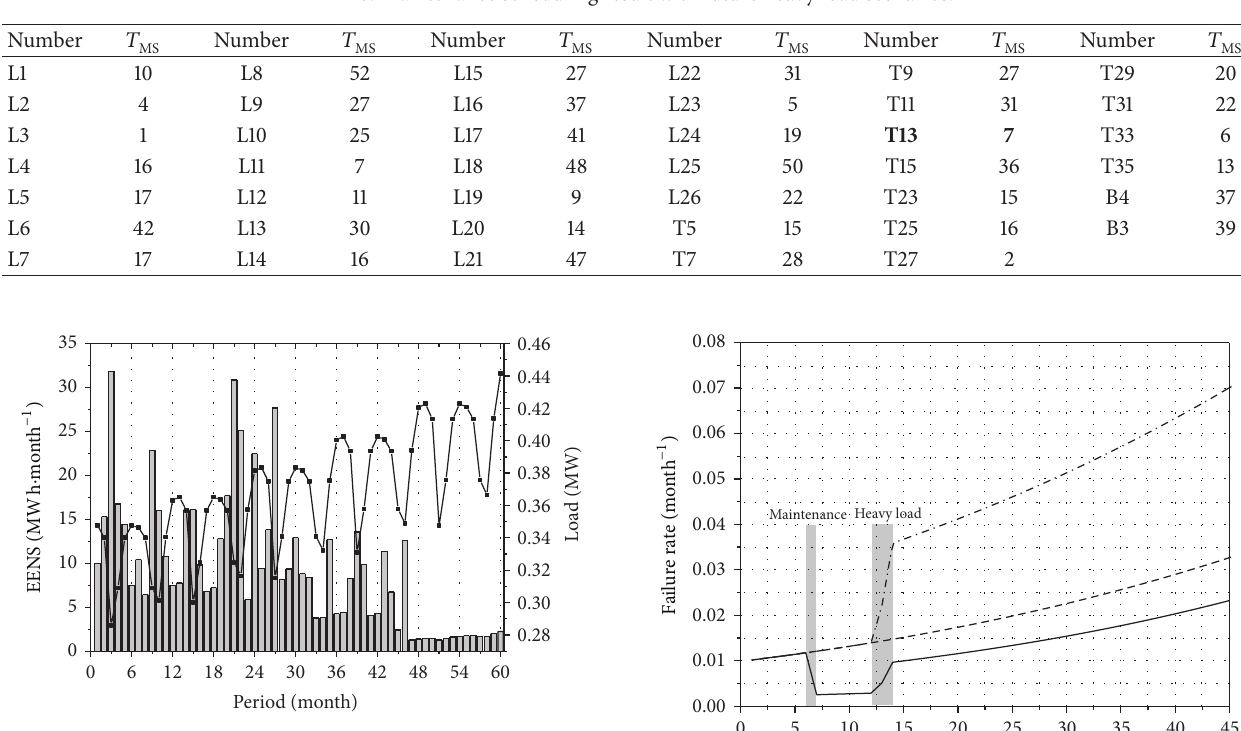
Table 6: Maintenance scheduling result with future heavy load scenarios.